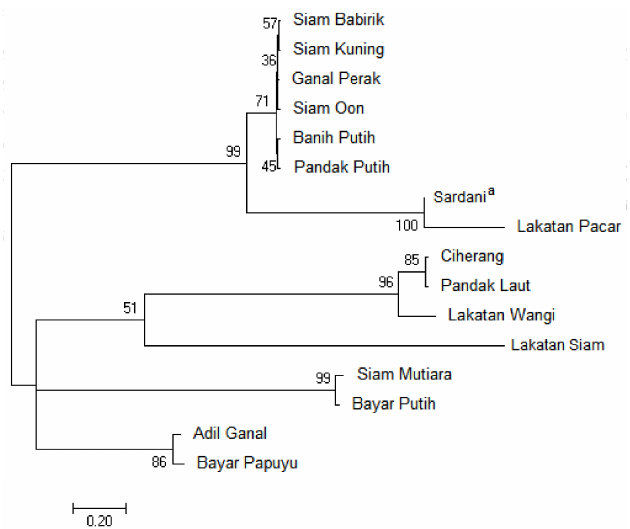
Figure 2. Phylogenetic tree of the tidal swamp rice based on the chloroplast trn L-F sequences. The numbers above branches indicate bootstrap values inferred from 1000 replicates ( a an outgroup).